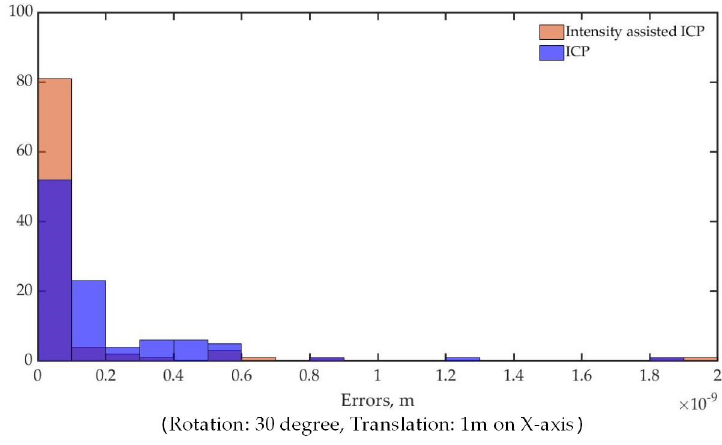
Figure 9. The final error convergence of intensity-assisted ICP and conventional ICP.